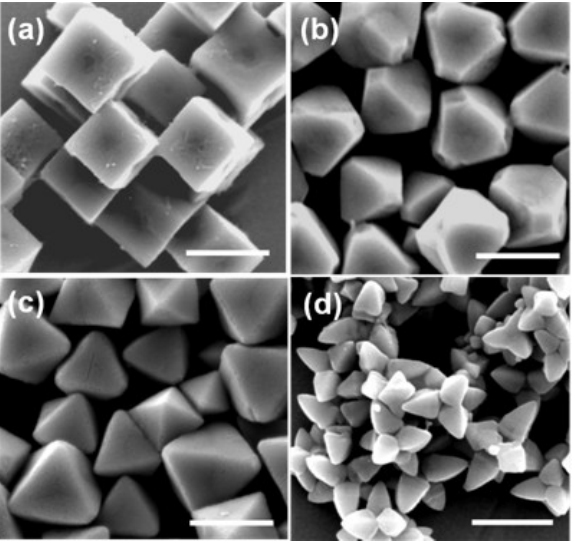
Figure 1. SEM images of synthesized Cu ( c ) Octahedra; and (d) Hexapods (Scale bar: 1 μm).